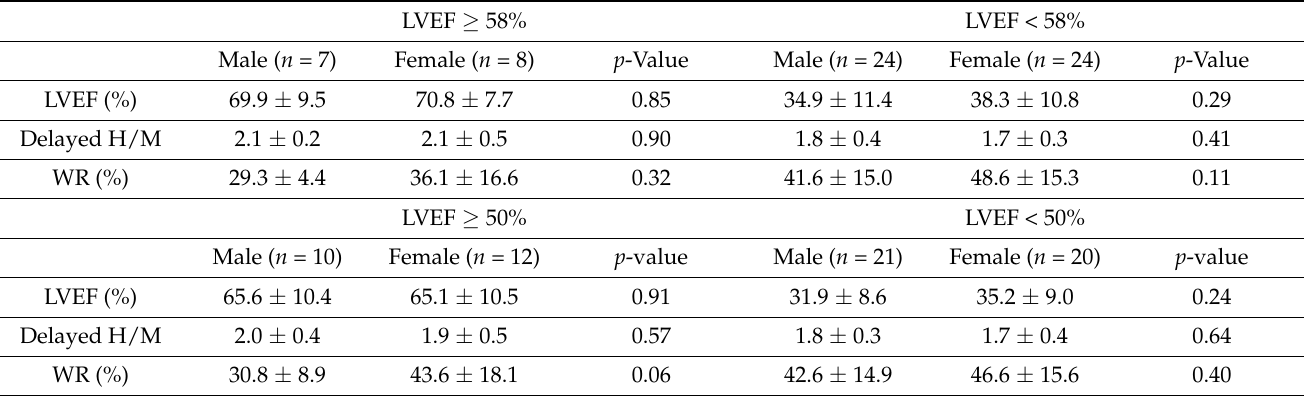
Table 4. Differences in LVEF and cardiac SNS activity by gender.